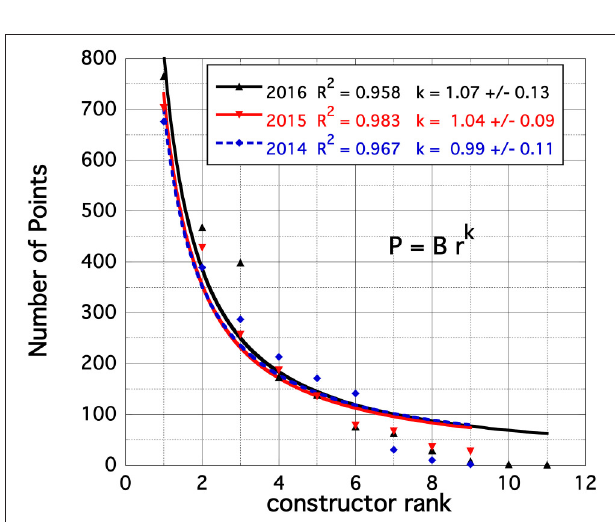
FIGURE 2 | Display of team ranking in F1 races at the end of 2016, 2015, and 2014.